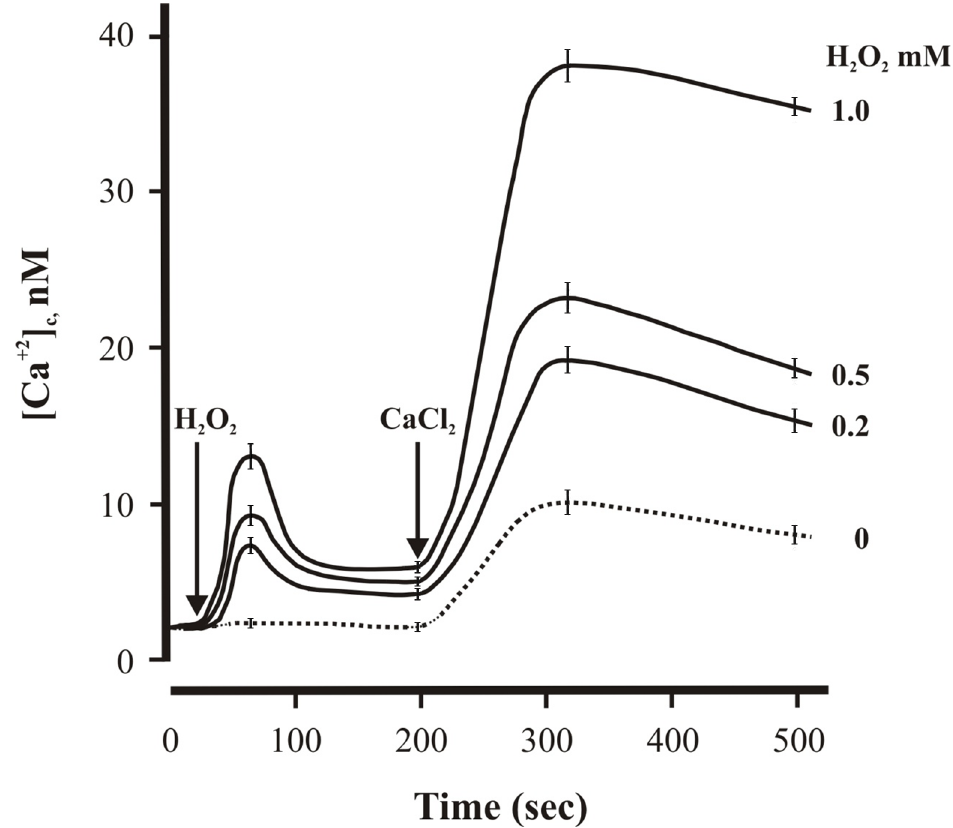
Fig 1. Oxidative stress by H 2 O 2 in sheep lymphomonocytes. Time-course of sheep lymphomonocytes (1x10 6 ) after treatment with H 2 O 2 (0.2, 0.5,1.0 mM) and, 200s later, 1mM CaCl 2 . Shown are levels (nM) of cytosolic calcium, measured at different time points. Each value calculated and expressed as the means from 5 experiments (biological replicates) ±